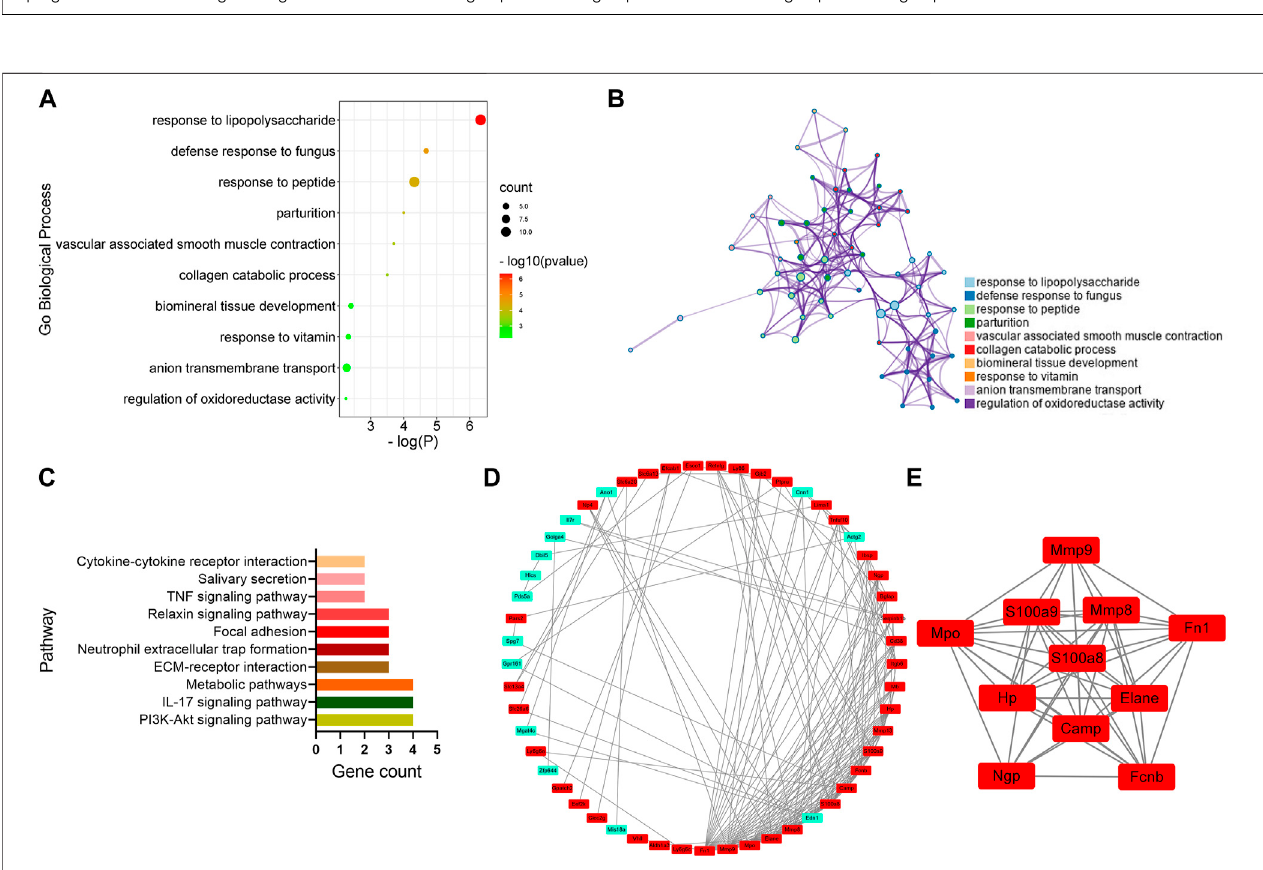
FIGURE 5 | GO, KEGG, and protein – protein interaction (PPI) network analysis of DEGs between the CFA+BoNT/A group vs. CFA group. (A,B) GO Biological Process enrichment of DEGs. (C) KEGG pathway enrichment of DEGs. (D) PPI network of DEGs. (E) A cluster was obtained by MCODE in Cytoscape.